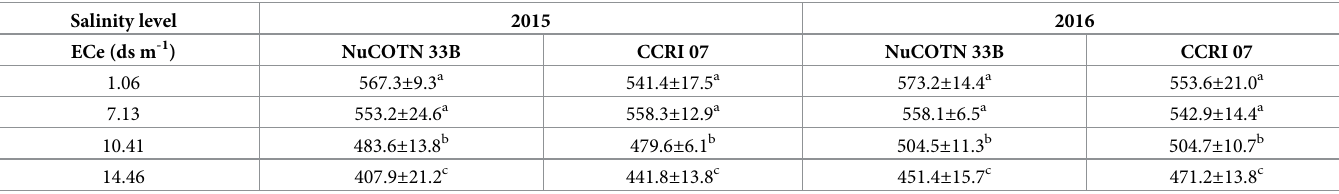
Table 2. Impacts of salinity on Bt protein content in cotton square (ng g -1 FW) of two Bt cultivars in field study during 2015 and 2016 (n = 4). Different letters repre- sent significant differences in the same column (Duncan multiple range tests, P < 0.05).